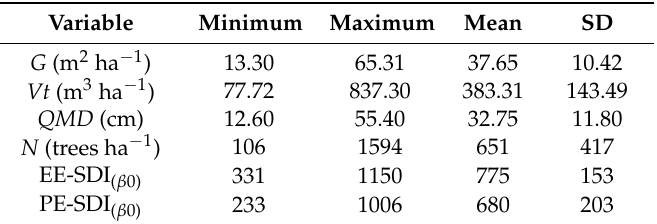
Table 1. Descriptive statistics of the dataset and stand-density index for QR-SDI-1 (EE-SDI ( β 0) ,